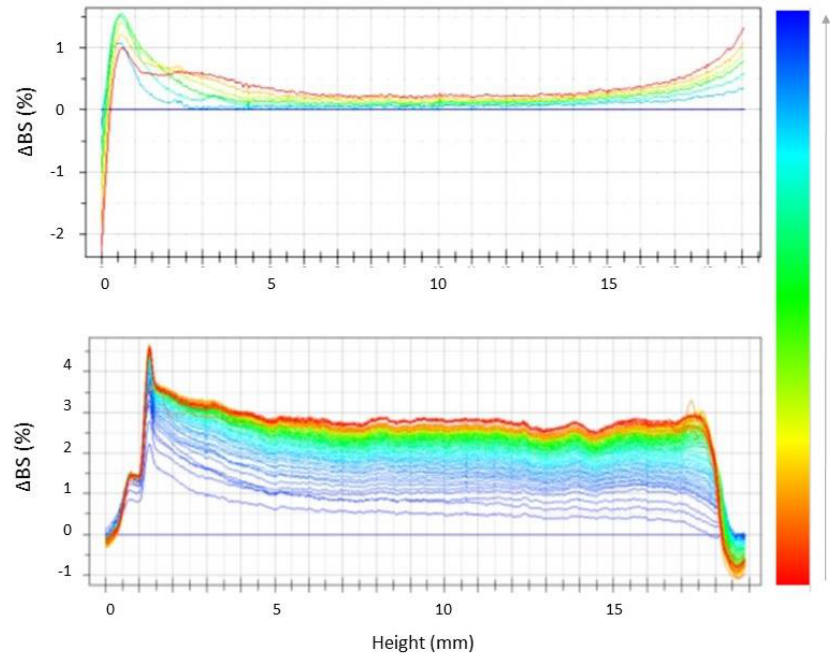
Figure 1. Backscattering profiles ( ∆ BS) of NLCa and NLCb stored in Turbiscan ® for 60 days at 25.0 ± 1.0 ◦ C. Data are presented as a function of time (0–60 days) of sample height (0 to 20 mm) (the direction of analysis time is indicated by the arrow).